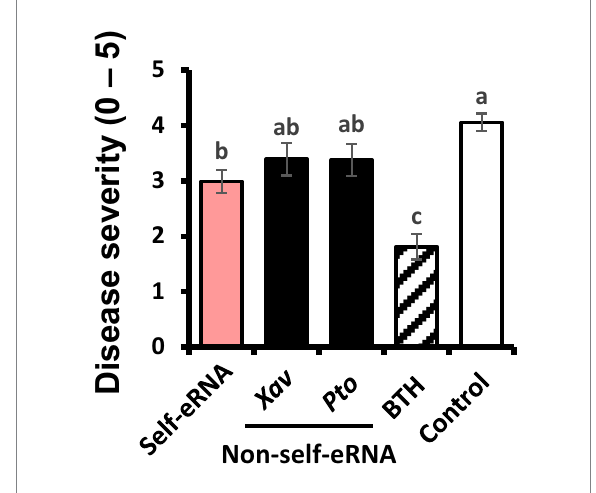
FIGURE 1 Activation of plant immunity in pepper plants treated with extracellular RNAs (eRNAs) and benzothiadiazole (BTH) under field conditions. Leaves of pepper plants were infiltrated with self-eRNA (derived from pepper plants) and non-self-bacterial eRNAs (OD 600 = 0.01; derived from virulent pathogens, Xanthomonas axonopodis pv. vesicatoria [ Xav ] and Pseudomonas syringae pv. tomato [ Pto ]), and disease severity was determined at 7 days post-infiltration. Data represent mean ± standard error of mean (SEM). Different letters indicate statistically significant differences between eRNA/BTH and water (control) treatments ( p = 0.05; least significant difference [LSD]